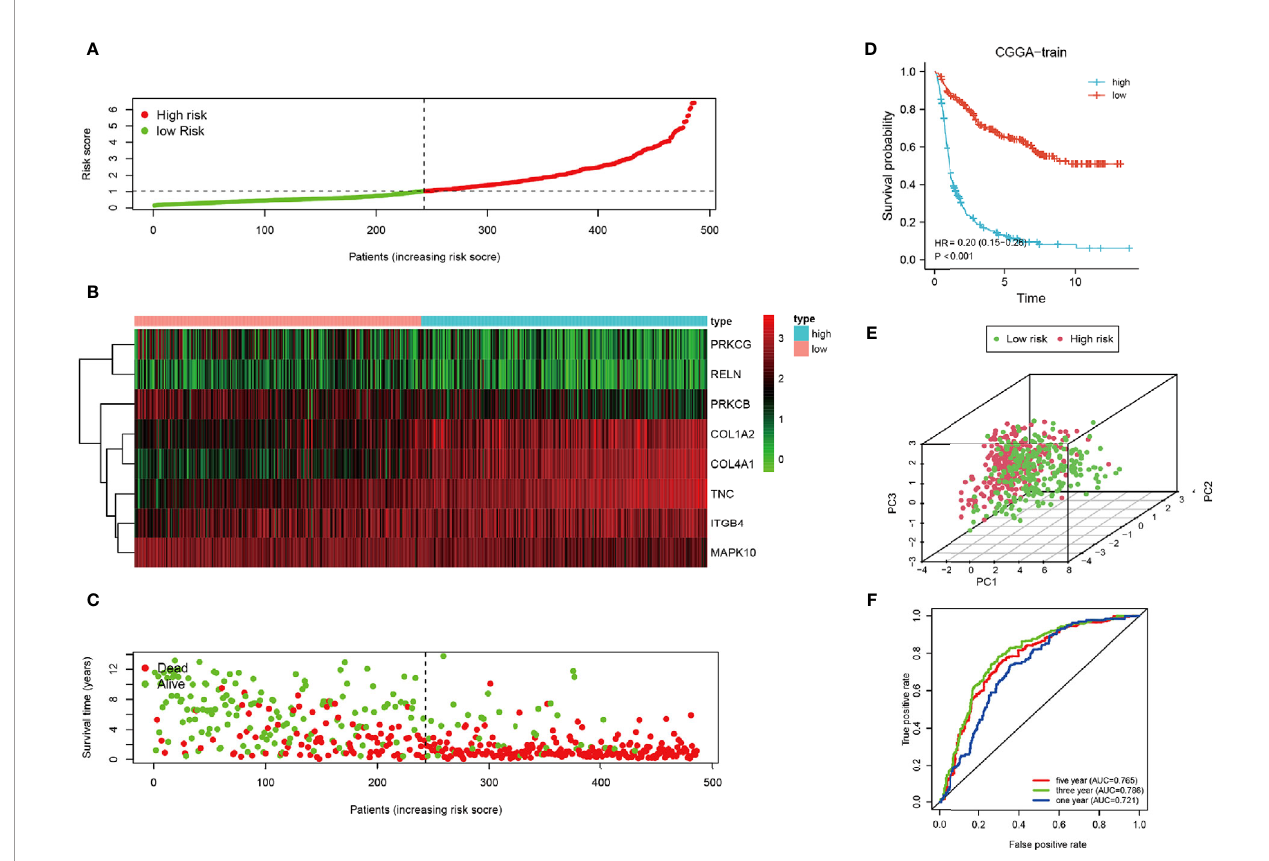
FIGURE 3 | Analysis of the CGGA training cohort. (A) Cutoff of low-and high-risk patients (B) Heatmap of expression of candidate genes. (C) Survival status of low-and high-risk patients. (D) Survival analysis of low- and high-risk patients. (E) PCA of low-and high-risk patients. (F) ROC of 1-, 3-, and 5-year